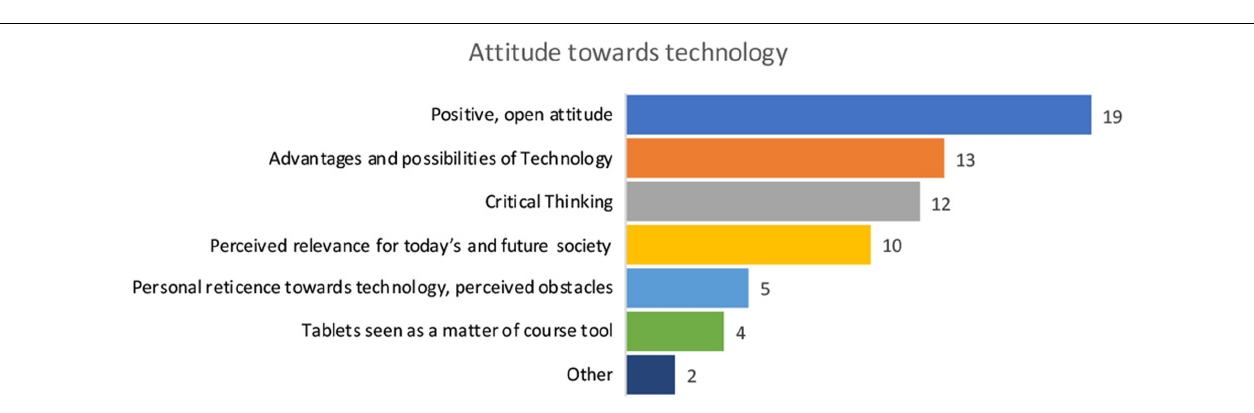
FIGURE 6 | Frequencies of interviews with mentions of the listed categories regarding the attitude toward